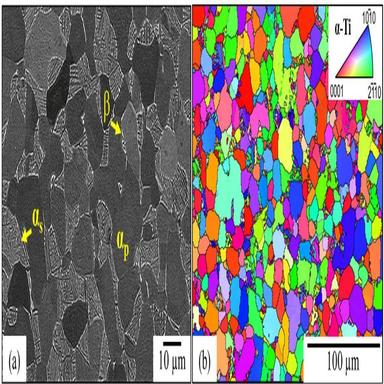
(a) Microstructure of the ex-service Ti-6Al-4V turbofan blade leading edge; (b) Colour-map showing different orientations of α-Ti grains.